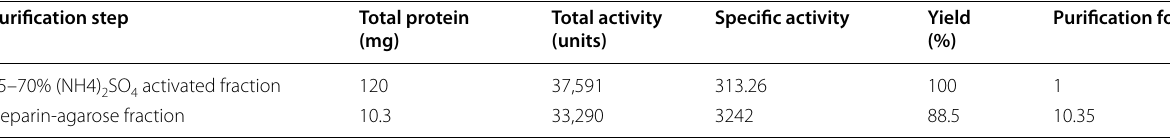
Table 1 Purification scheme of the camel thrombin Purification